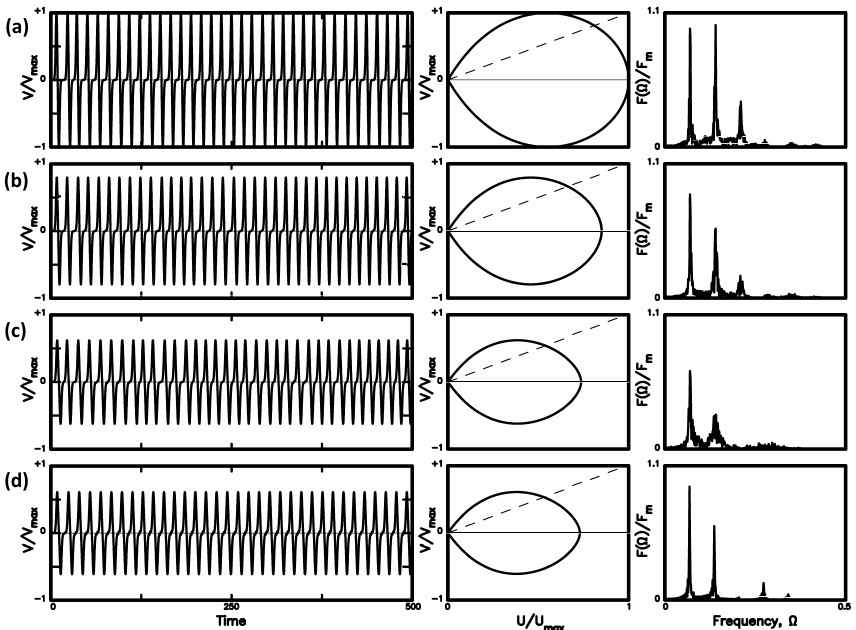
Figure 7. The time variation in V/V max , the phase portrait of V/V max versus U/U max , and the power spectrum for four values of η : (a) for